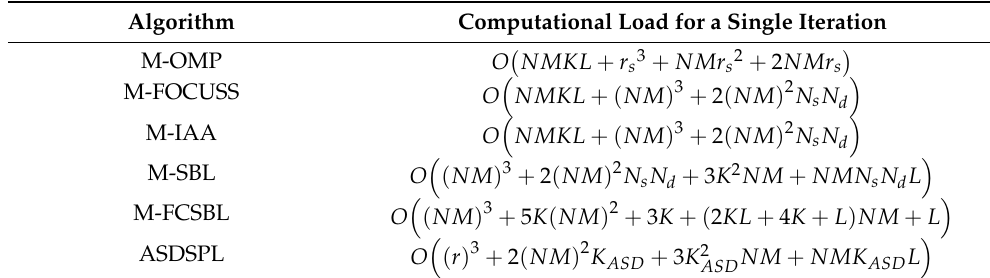
Table 1. Computational complexity comparison.